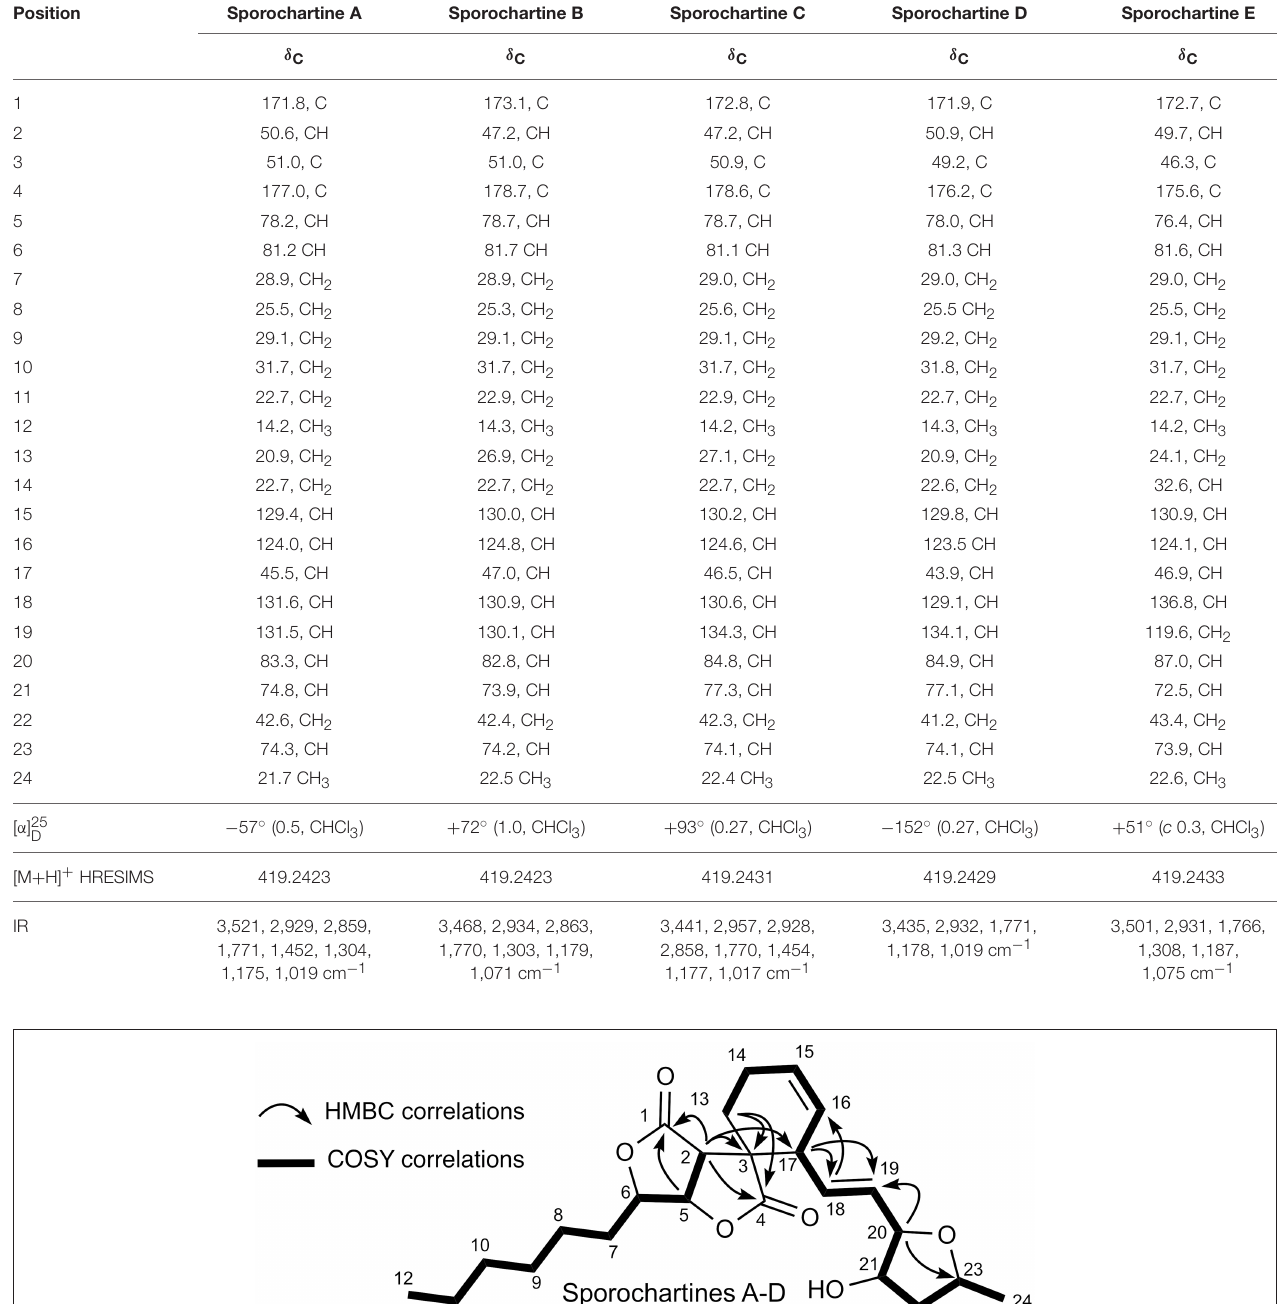
TABLE 2 | 13 C NMR data for sporochartines A–E (Data acquired in CDCl 3 at 125 MHz). Position